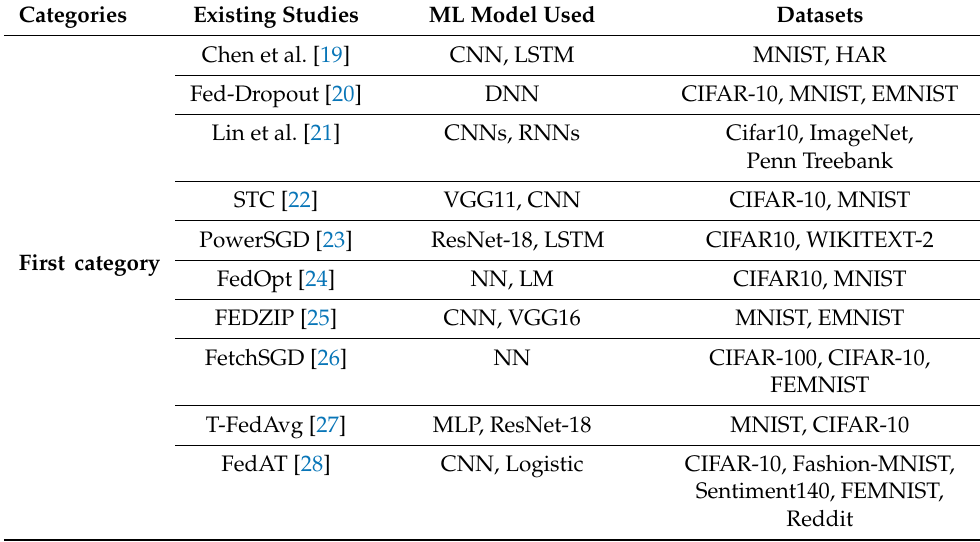
Table 1. Summary of recent studies to minimize communication overhead in